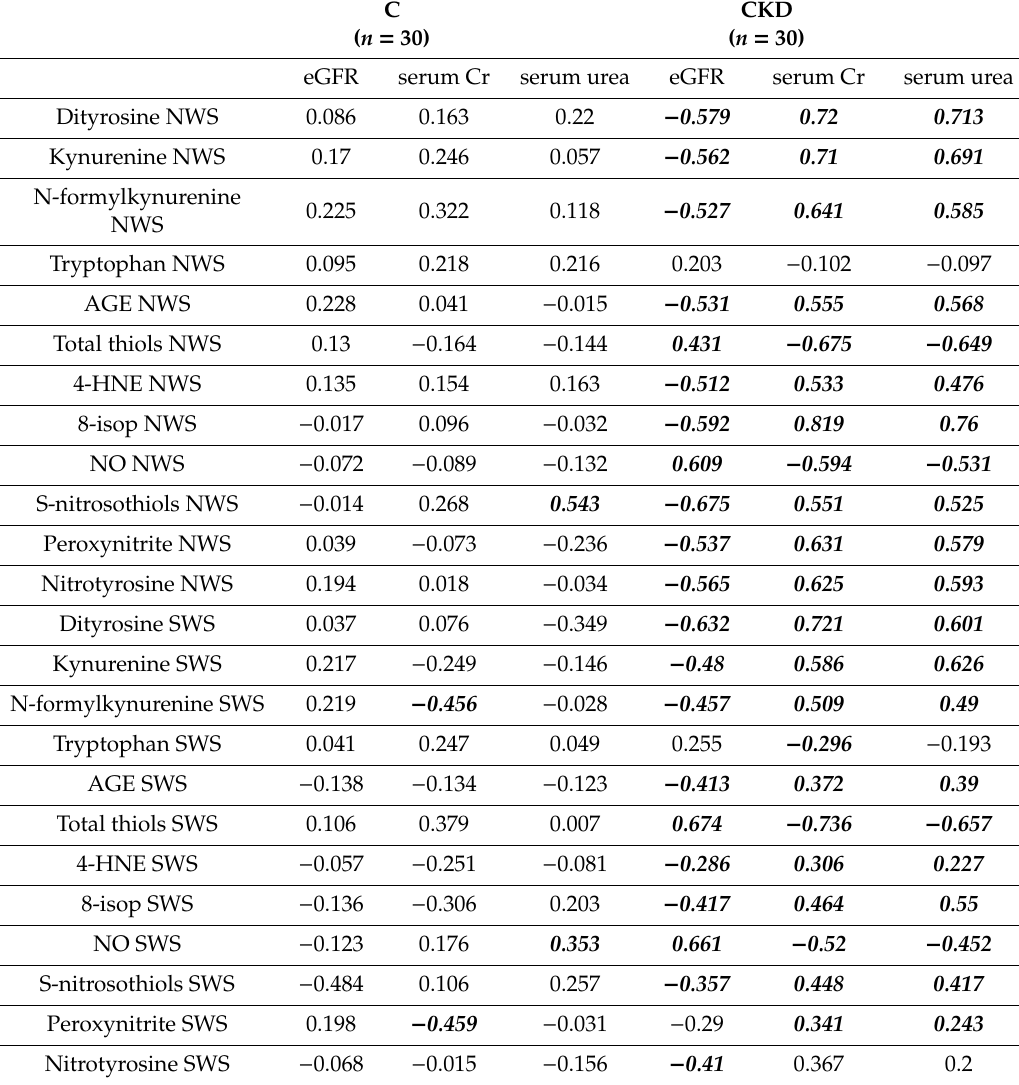
Table 3. Correlations between analyzed redox biomarkers and renal function of children with chronic kidney disease (CKD) and healthy